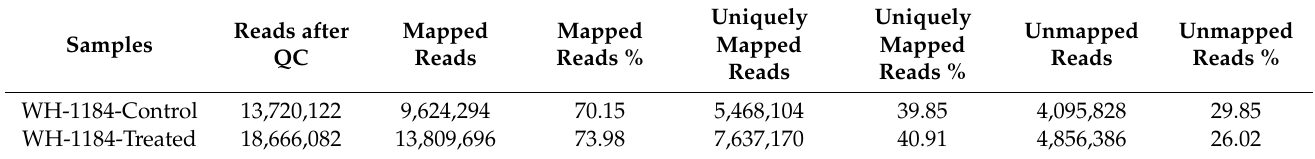
Table 3. Read alignment statistics of reads using STAR2 aligner.